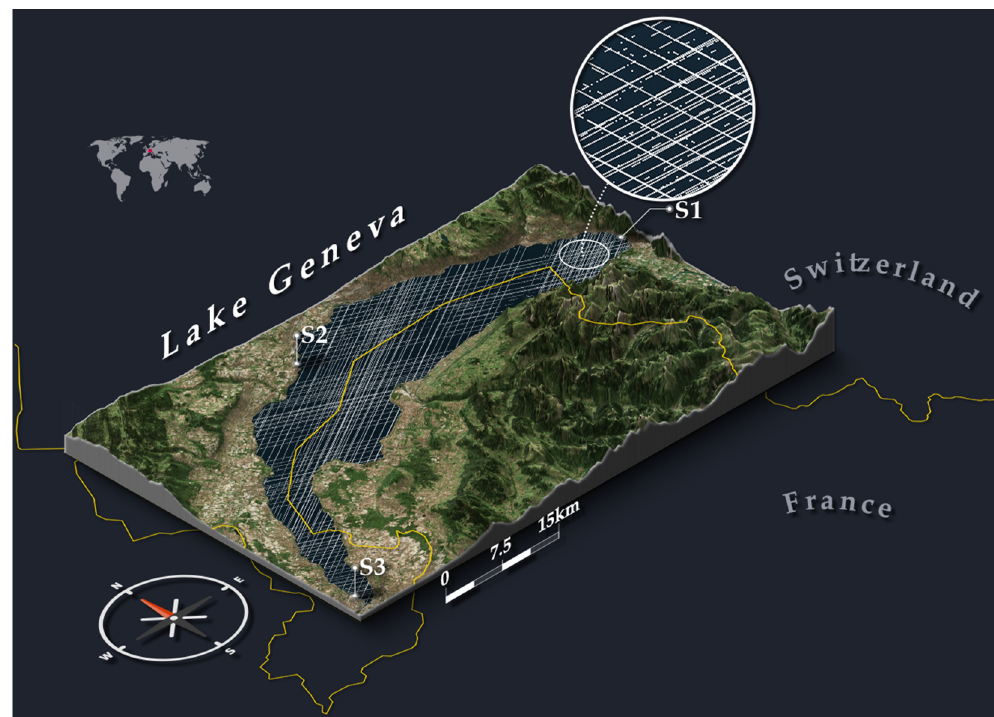
Figure 1. Distribution of the 51,807 GEDI shots (white points) after filtering of the GEDI dataset over Lake Geneva. The yellow lines represent country borders.